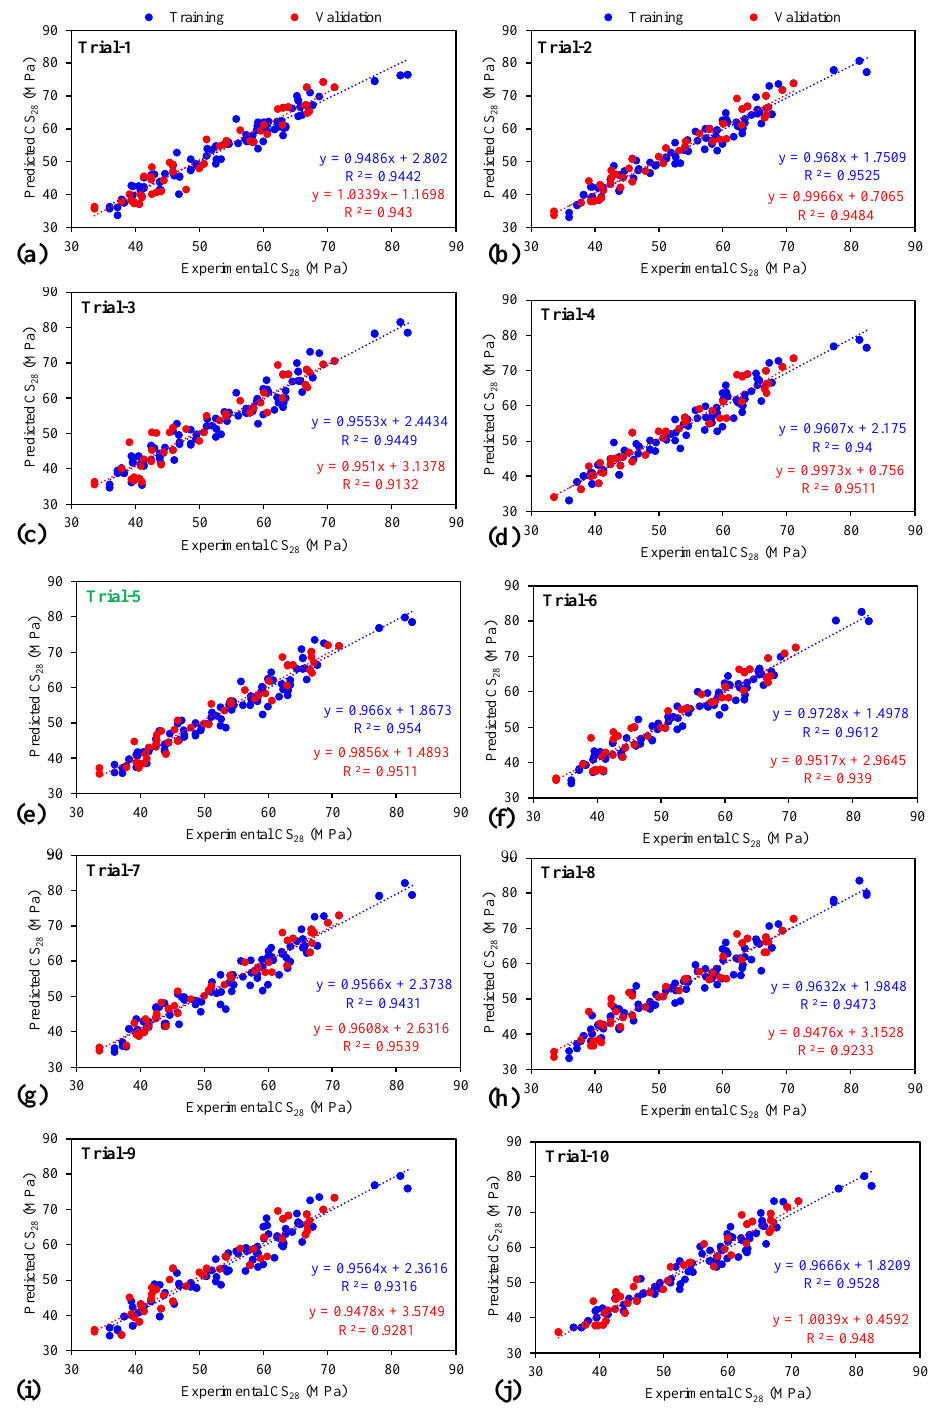
Figure 3. Comparison of the regression slopes between experimental and predicted results for all the ( a – j ) 10 GEP trials using different combinations of hyper parameters.